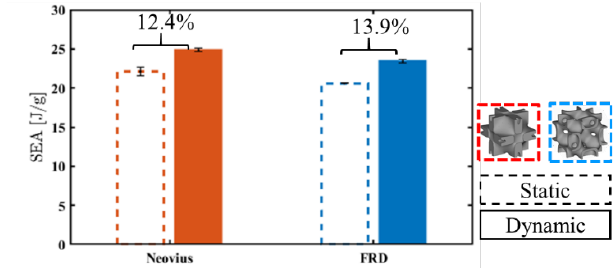
Fig. 7 . SEA of Neovius and FRD TPMS lattices under static and dynamic